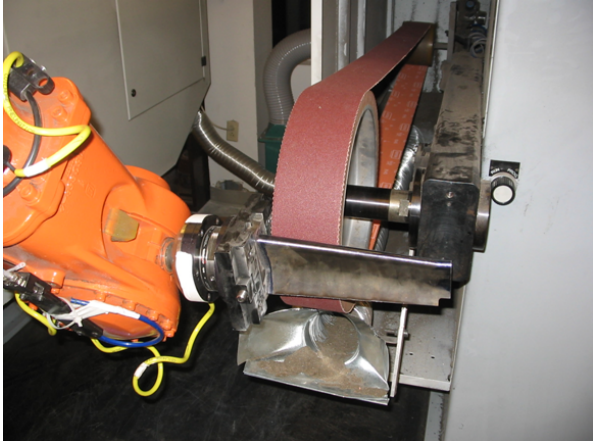
Figure 11: Example of installation using force con- trolled grinding of a turbine